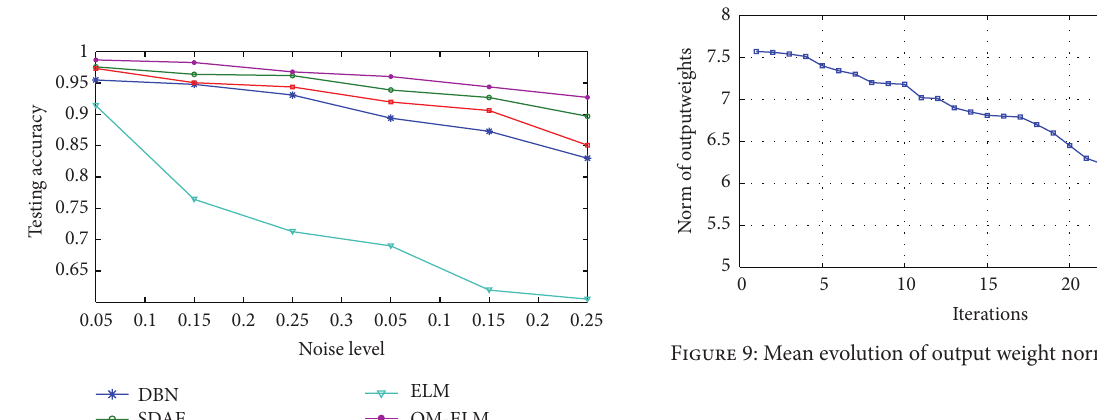
Figure 6: Mean classification accuracies of the 6 methods of different conditions.